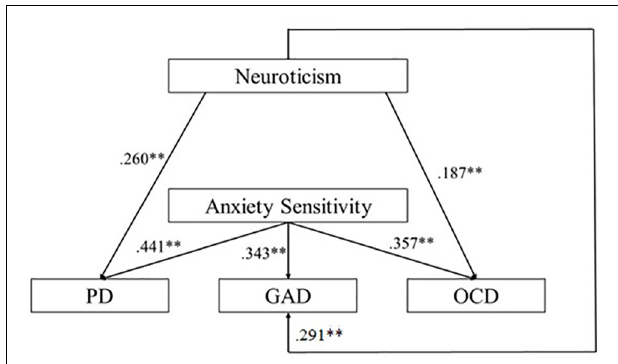
FIGURE 1 | Summary of the first hypothesized model with standardized path coefficients (PD, panic disorder; GAD, generalized anxiety disorder; OCD, obsessive-compulsive disorder) ( ∗ for p -values < 0.05; ∗∗ for p -values <